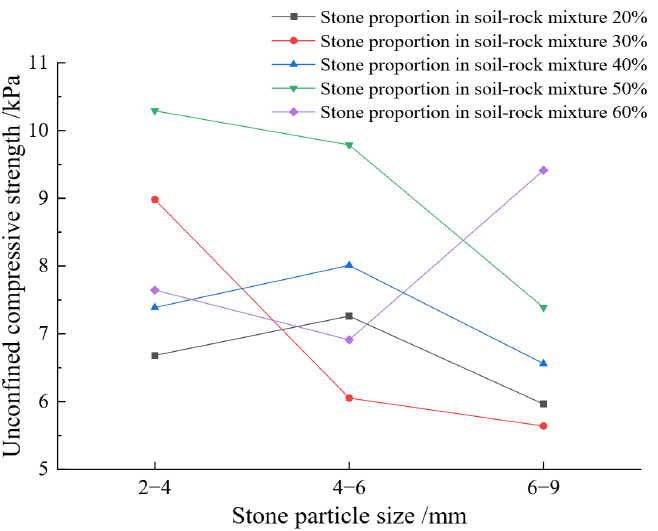
Figure 9. Unconfined compressive strength of soil–rock mixture samples with different stone particle